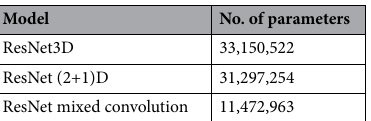
Table 1. Total number of trainable parameters for each